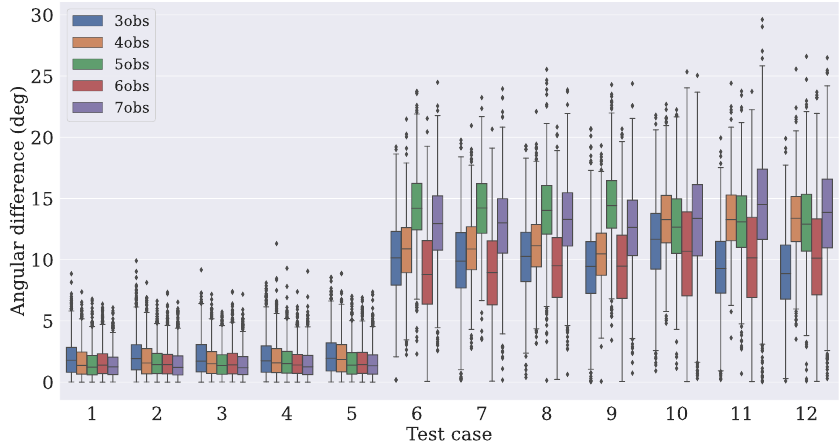
Figure 7. Dispersion of the absolute angular difference when using a dropout rate of 10%.